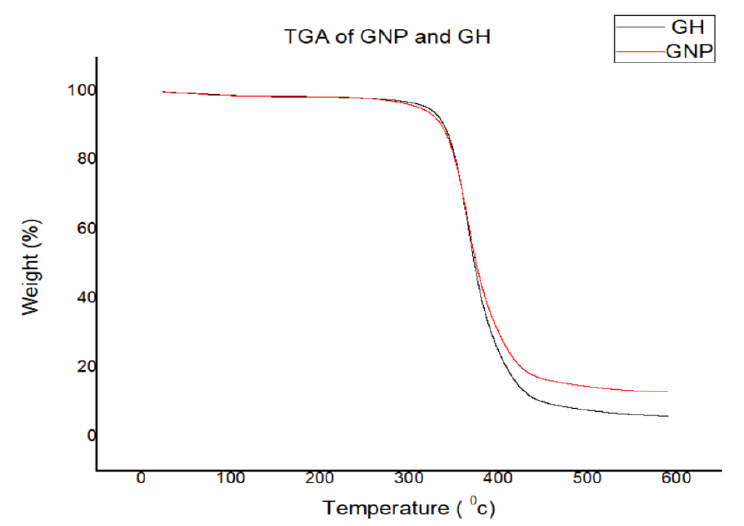
Figure 6. TGA test results of nanocomposites reinforced with optimised wt % of GNP and GH.